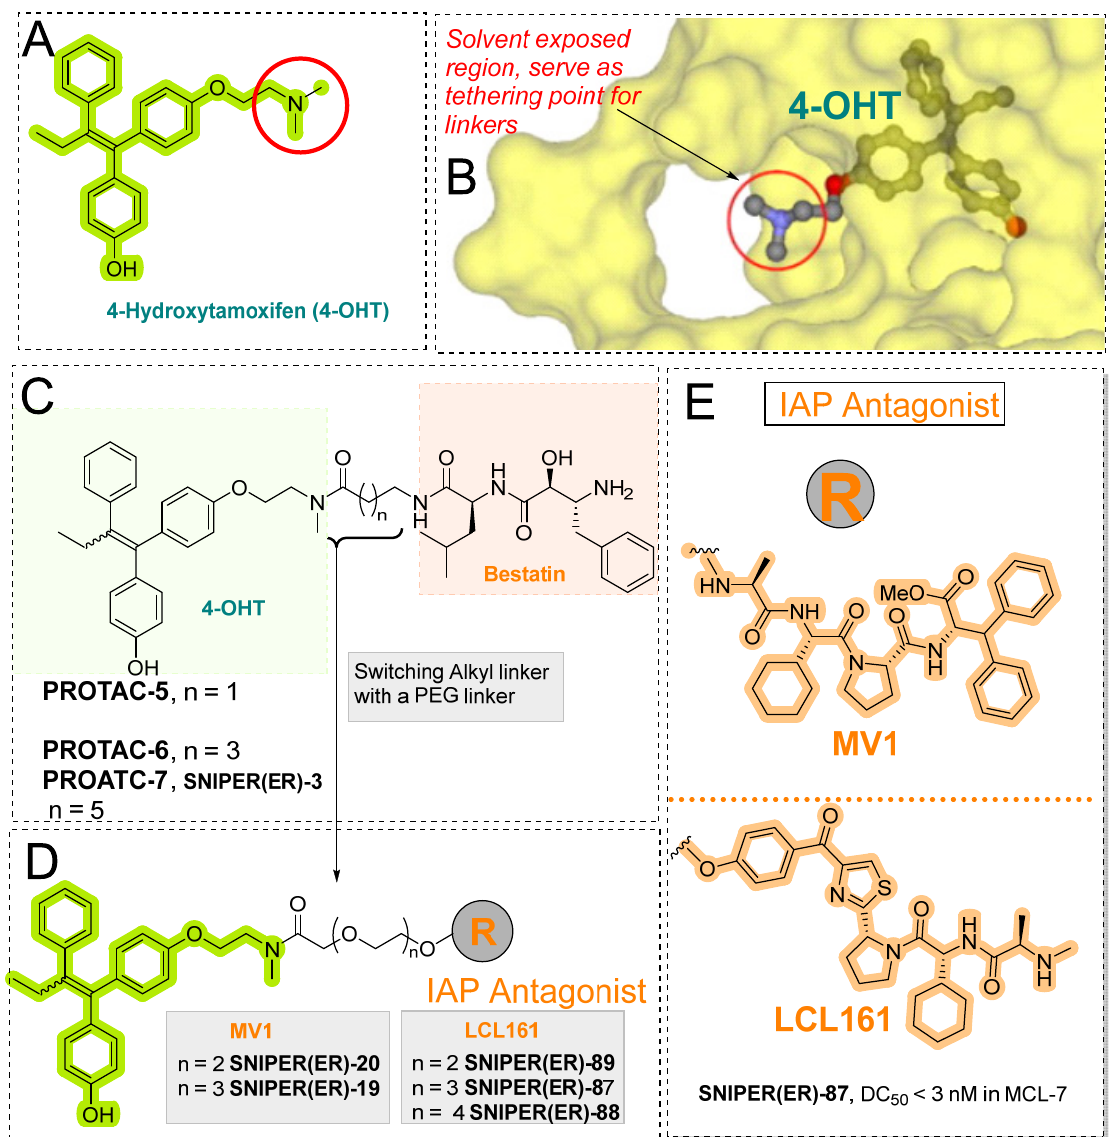
Figure 14. ( A ) Cocrystal structure (PDB id: 3ERT) of 4-hydroxytamoxifen (4-OHT) and ER- α , showing the solvent-exposed region of 4-OHT. ( B ) Molecular structure of 4-OHT. ( C ) Molecular structure of PROTAC-5, 6, and 7. ( D ) General structure of SNIPER(ER)s where linker of PROTAC-7 (SNIPER(ER)-3) was replaced with polyethylene glycol (PEG). ( E ) Molecular structures of IAP ligands.